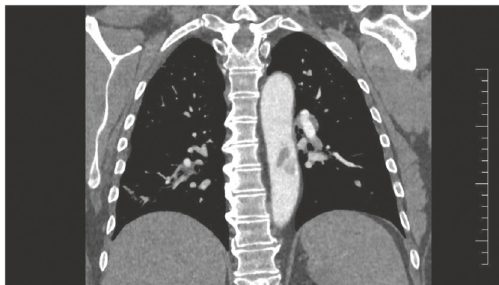
Figure 2: Fluttering aortic thrombosis on CTangiography (case no.